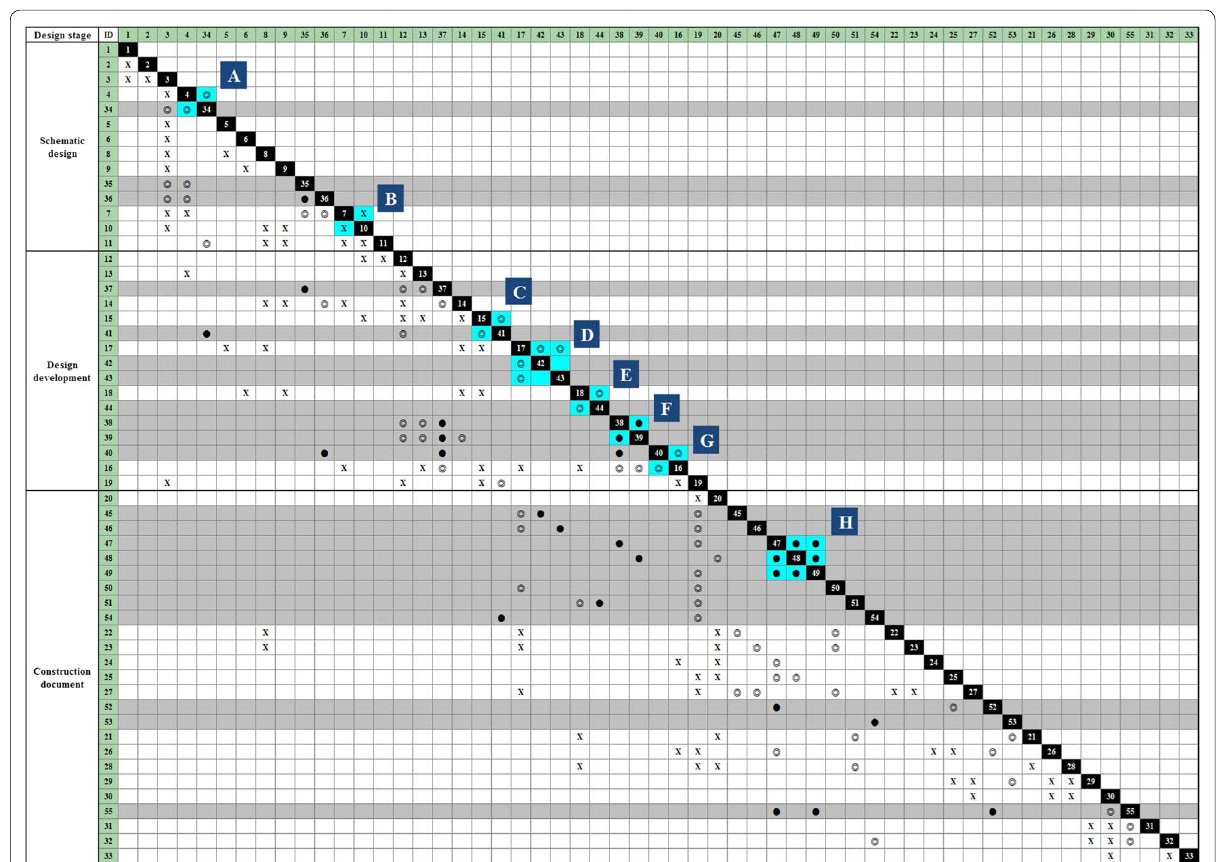
Fig. 2 Partitioned dependency structure